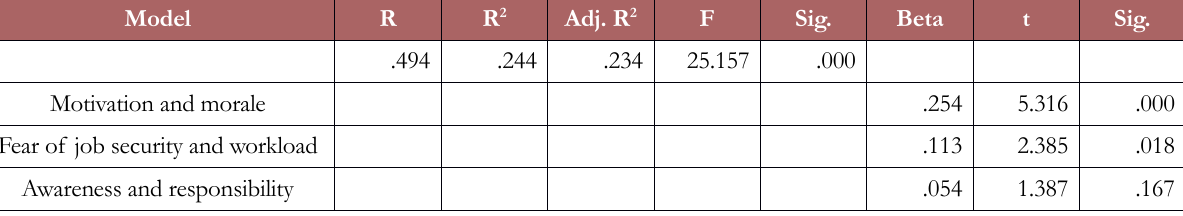
Table 9. Multiple simultaneous regression analysis for dimensions of psychological factors- implementation of 5S and